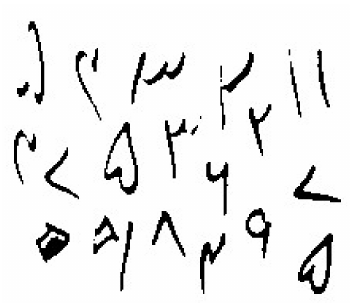
Figure 5. Application of Gaussian filter.